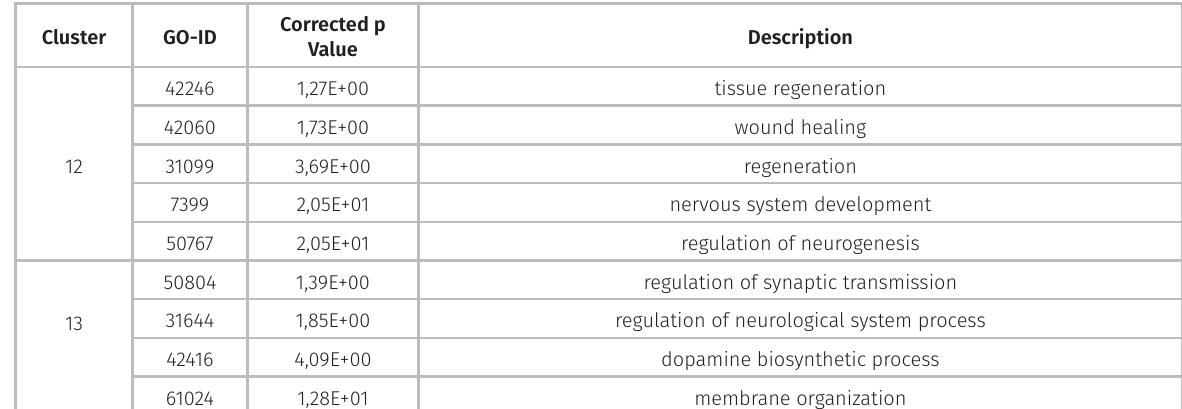
membrane organization